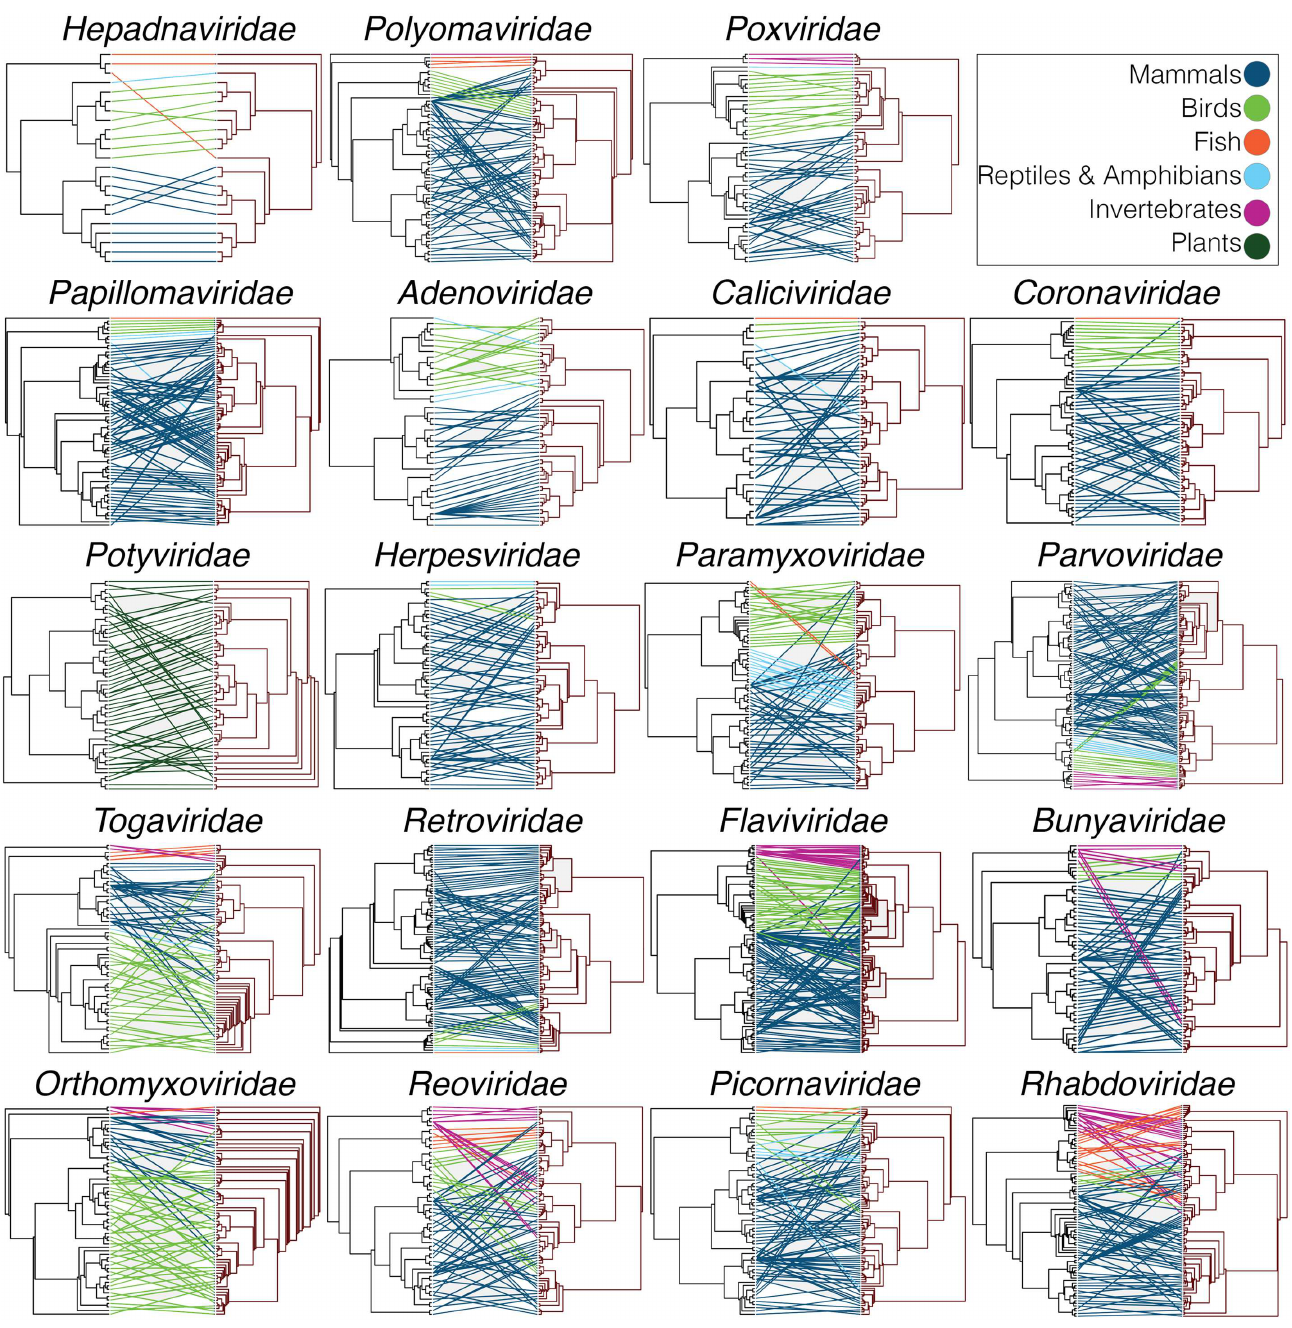
Fig 4. Tanglegrams of rooted phylogenetic trees for each virus family. Host trees were rooted first followingtheir known phylogenetic history, with virus trees then rooted based on the host tree. The ‘untangle’function was used to maximizethe congruence betweenthe host and virus phylogenies. Lines that connect the host (left) with its virus (right) are colored accordingto the host type (dark blue: mammals; light green: birds; light blue: reptiles and amphibians; red: fish; pink: invertebrates; dark green: plants). Phylogenieswith the individual tip labels visibleare shown in S1 Fig.